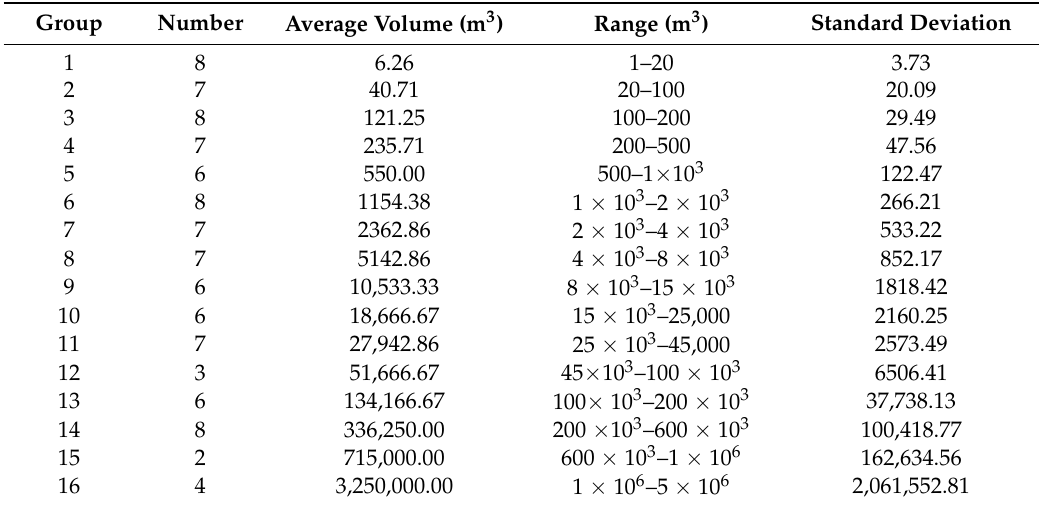
Table 2. Result of landslide groups according to their